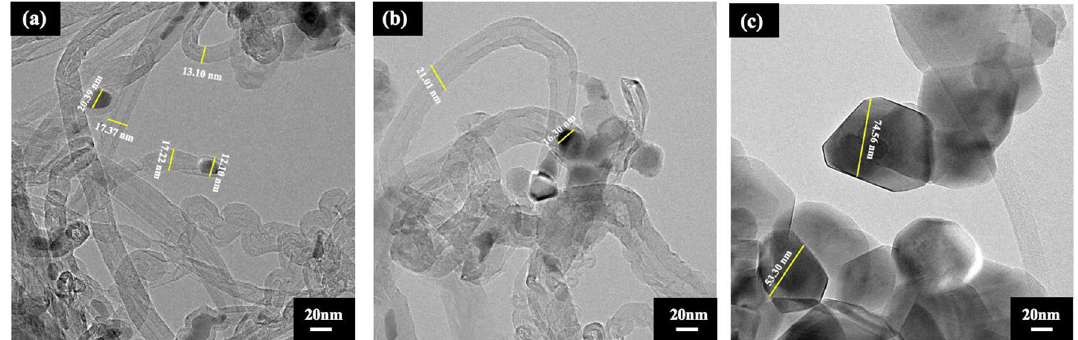
Figure 12. HR - TEM micrographs of the samples after running at 800 °C for 3 h over FeNiMo/MgO catalyst under ( a ) CH 4 /He, ( b ) CH 4 /CO 2 , ( c ) He/CO 2 , GHSV = 48,000